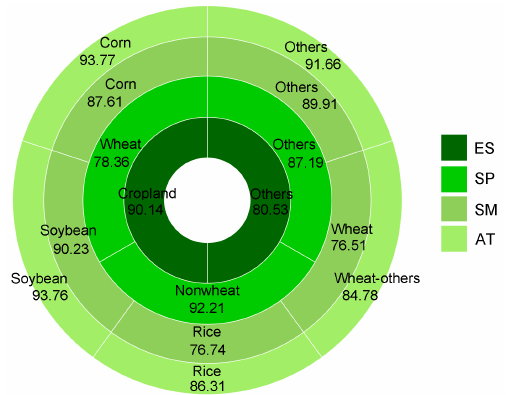
Figure 7. Circular plots representing the class-wise accuracy (F-score) of the RF classifier for Scenario T m SVT x ’. ES in the early spring season; SP in the spring season; SM in the summer season; AT in the autumn season.